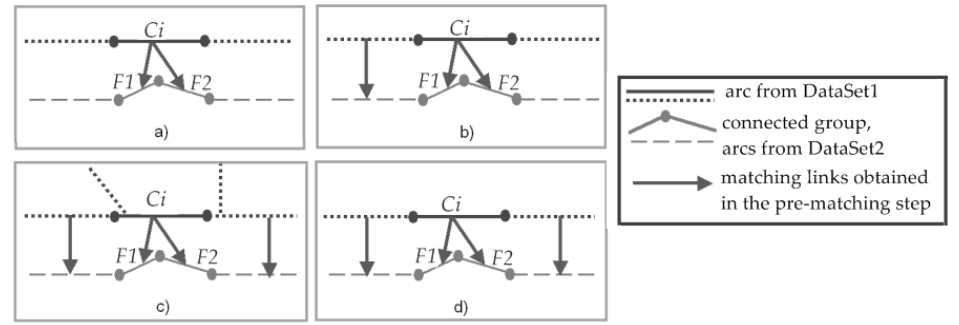
Figure 4: Different cases of matching results for